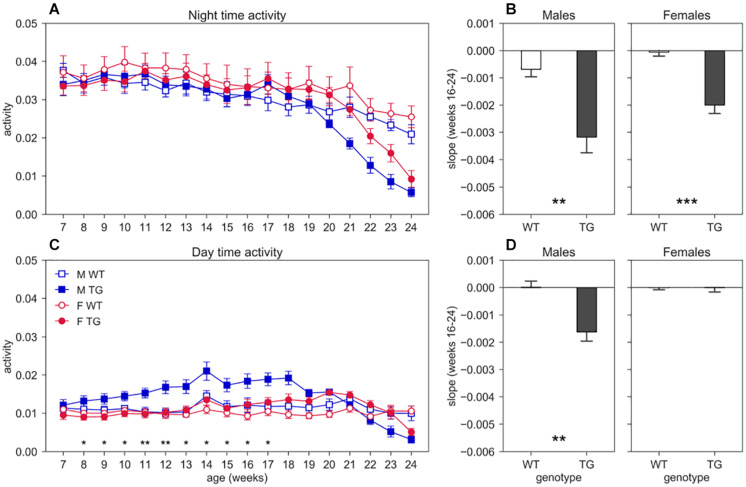
Night and day time activity. Average weekly activity (±SEM) over night (A) and day (C) time across 7–24 weeks of age in male (M, blue squares) and female (F, red circles) cages of WT (open symbols) and SOD1G93A (TG, filled symbols) mice. N of cages per group: M WT = 8; M TG = 9; F WT = 11; F TG = 10. We found no significant D/AP post-hoc test (until week 20) when comparing day activity between WT and TG with both males and females. Since we found a significant Genotype X Sex X Age interaction for day time activity (nparLD test, Genotype X Sex X Age interaction: Statistic = 2.356, df = 4.161, p < 0.05) we compared TG males with TG females with D/AP post-hoc procedure in C (*p < 0.05, **p < 0.01, black stars). We observed a clear decreasing trend of day and night activity in TG mice compared to WT, but we could not perform tests after week 20, since some cages were missing. Panel (B) shows the slope of the linear regression computed for the weekly night time activity points in weeks of age 16–24, while panel (D) shows the results for day time activity. (**p < 0.01, ***p < 0.001 two sample T-test).